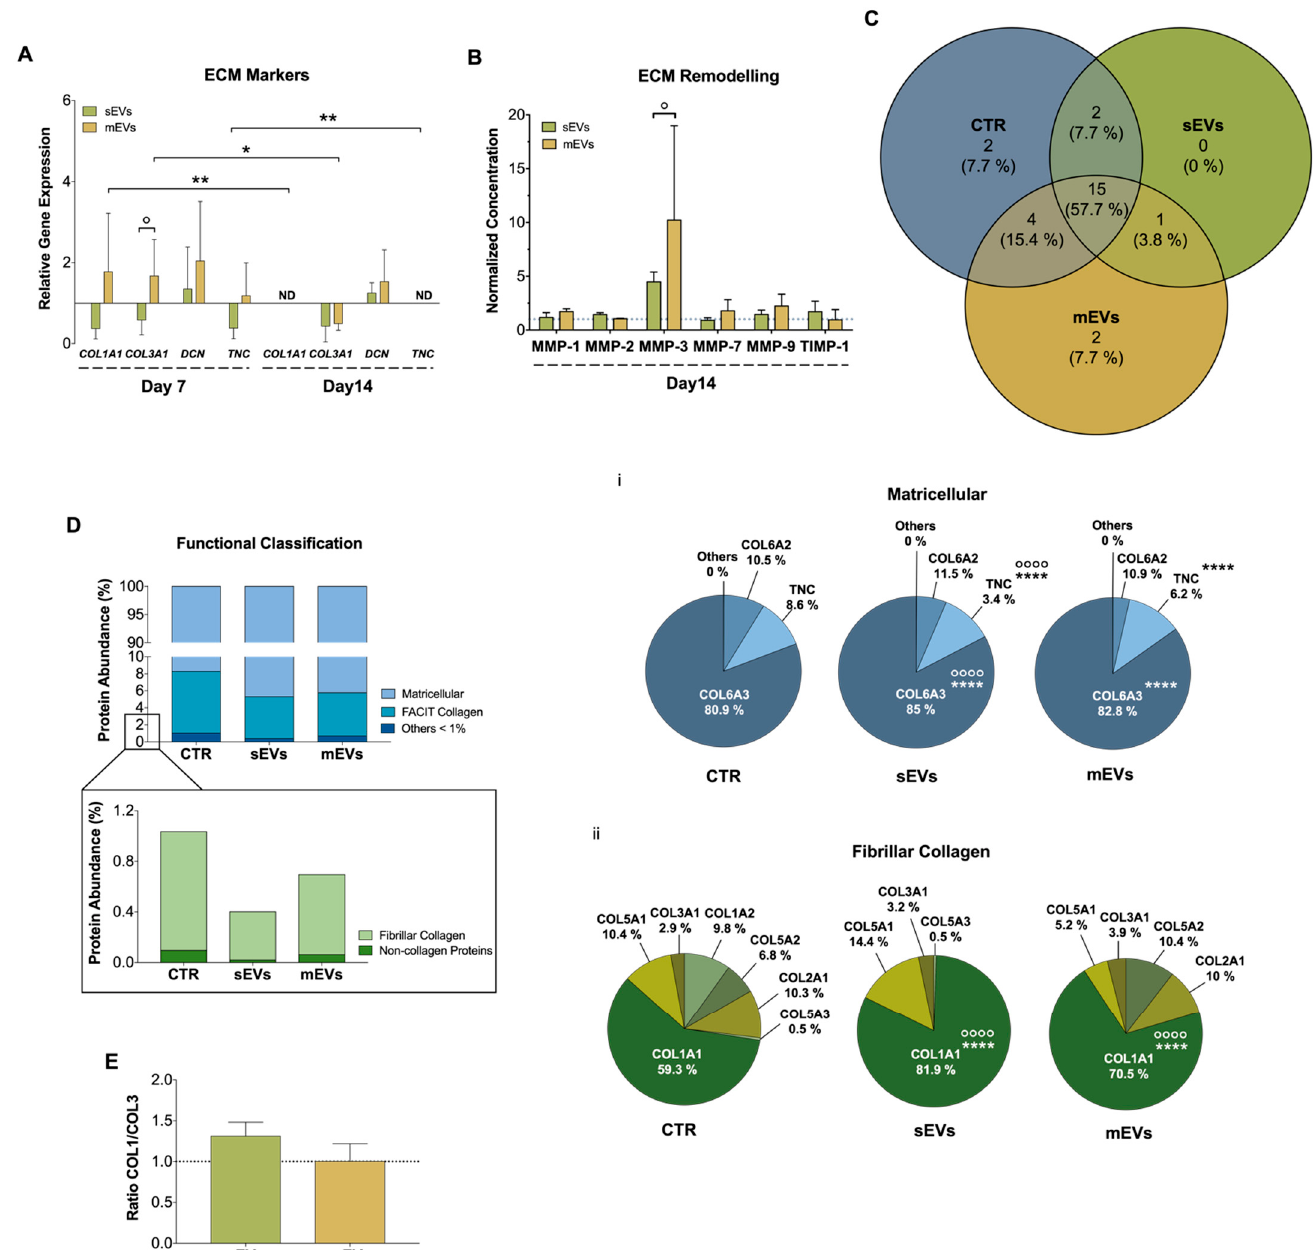
Figure 3. ( A ) Gene expression of tendon-related extracellular matrix (ECM) markers, collagen type I alpha 1 chain ( COL1A1 ), collagen type III alpha 1 chain ( COL3A1 ), decorin ( DCN ), and tenascin ( TNC ), after 7 and 14 days with small extracellular vesicles (sEVs) and medium extracellular vesicles (mEVs). Expression of target genes normalized against the reference genes glyceraldehyde-3- phosphate dehydrogenase ( GADPH ) and glucuronidase beta ( GUSB ) and gene expression normalized at the control of each day (1) (n = 4). Statistical differences: * p < 0.05, ** p < 0.01 (among days for the same group); ° p < 0.05 (sEVs against mEVs). ( B ) Concentration of matrix metalloproteinase-1, -2, -3, -7 and -9 (MMP-1, MMP-2, MMP-3, MMP-7, and MMP-9) and tissue